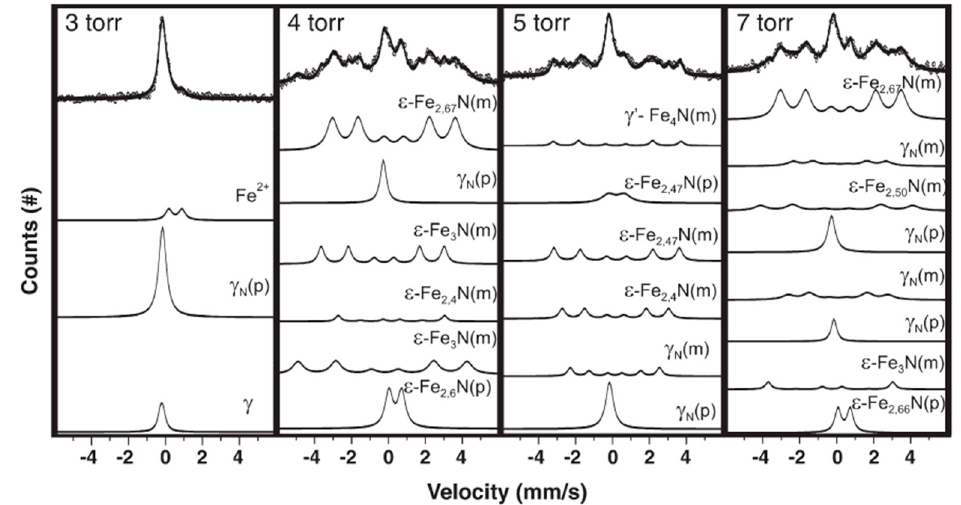
Figure 17. CEMS profiles of austenitic stainless steel plasma nitrided at different pressures (see text for identification of spectral components). Reproduced from [45], with permission from Elsevier, 2010.